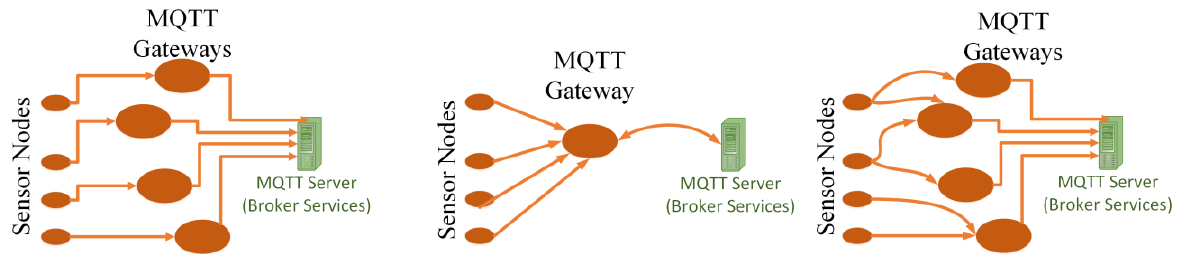
Figure 1. Logical Formation of MQTT gateways in IoT for various applications ( a ) Transparent Gateway MQTT, ( b ) Aggregated Gateway MQTT and ( c ) Hybrid Gateway MQTT